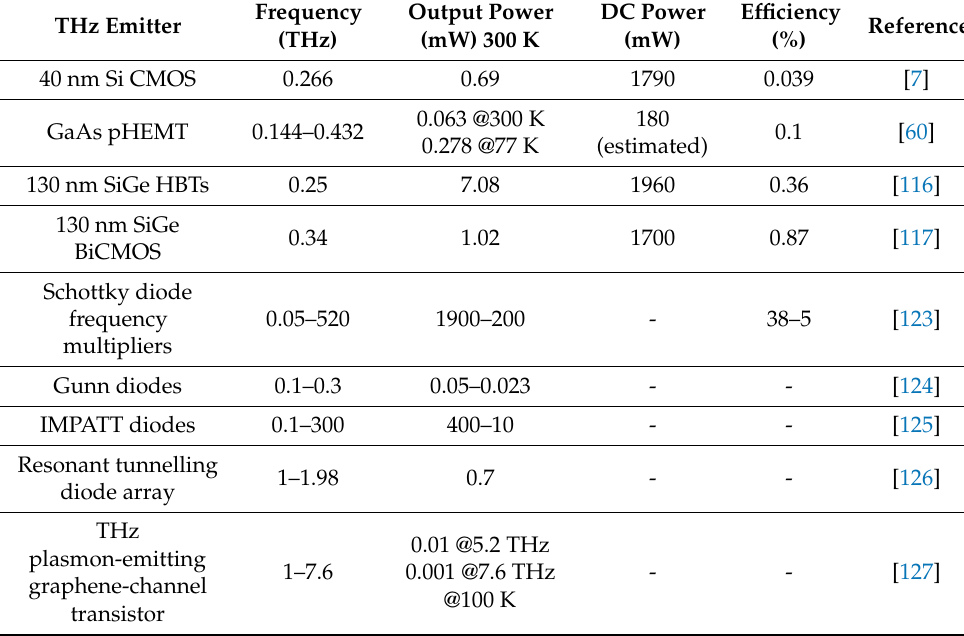
Table 3. THz electronic sources operating at 300 K unless stated otherwise (see also